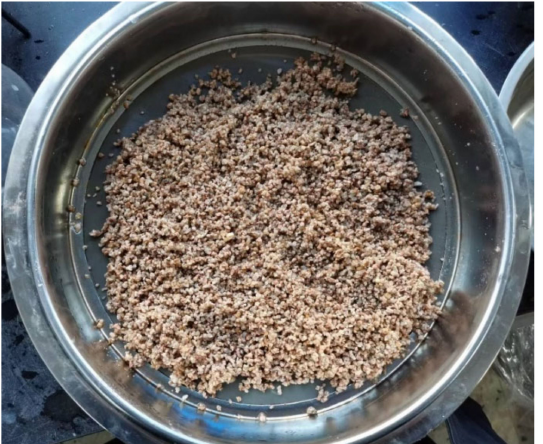
Figure 8. Determination of the water absorption of particles larger than 2